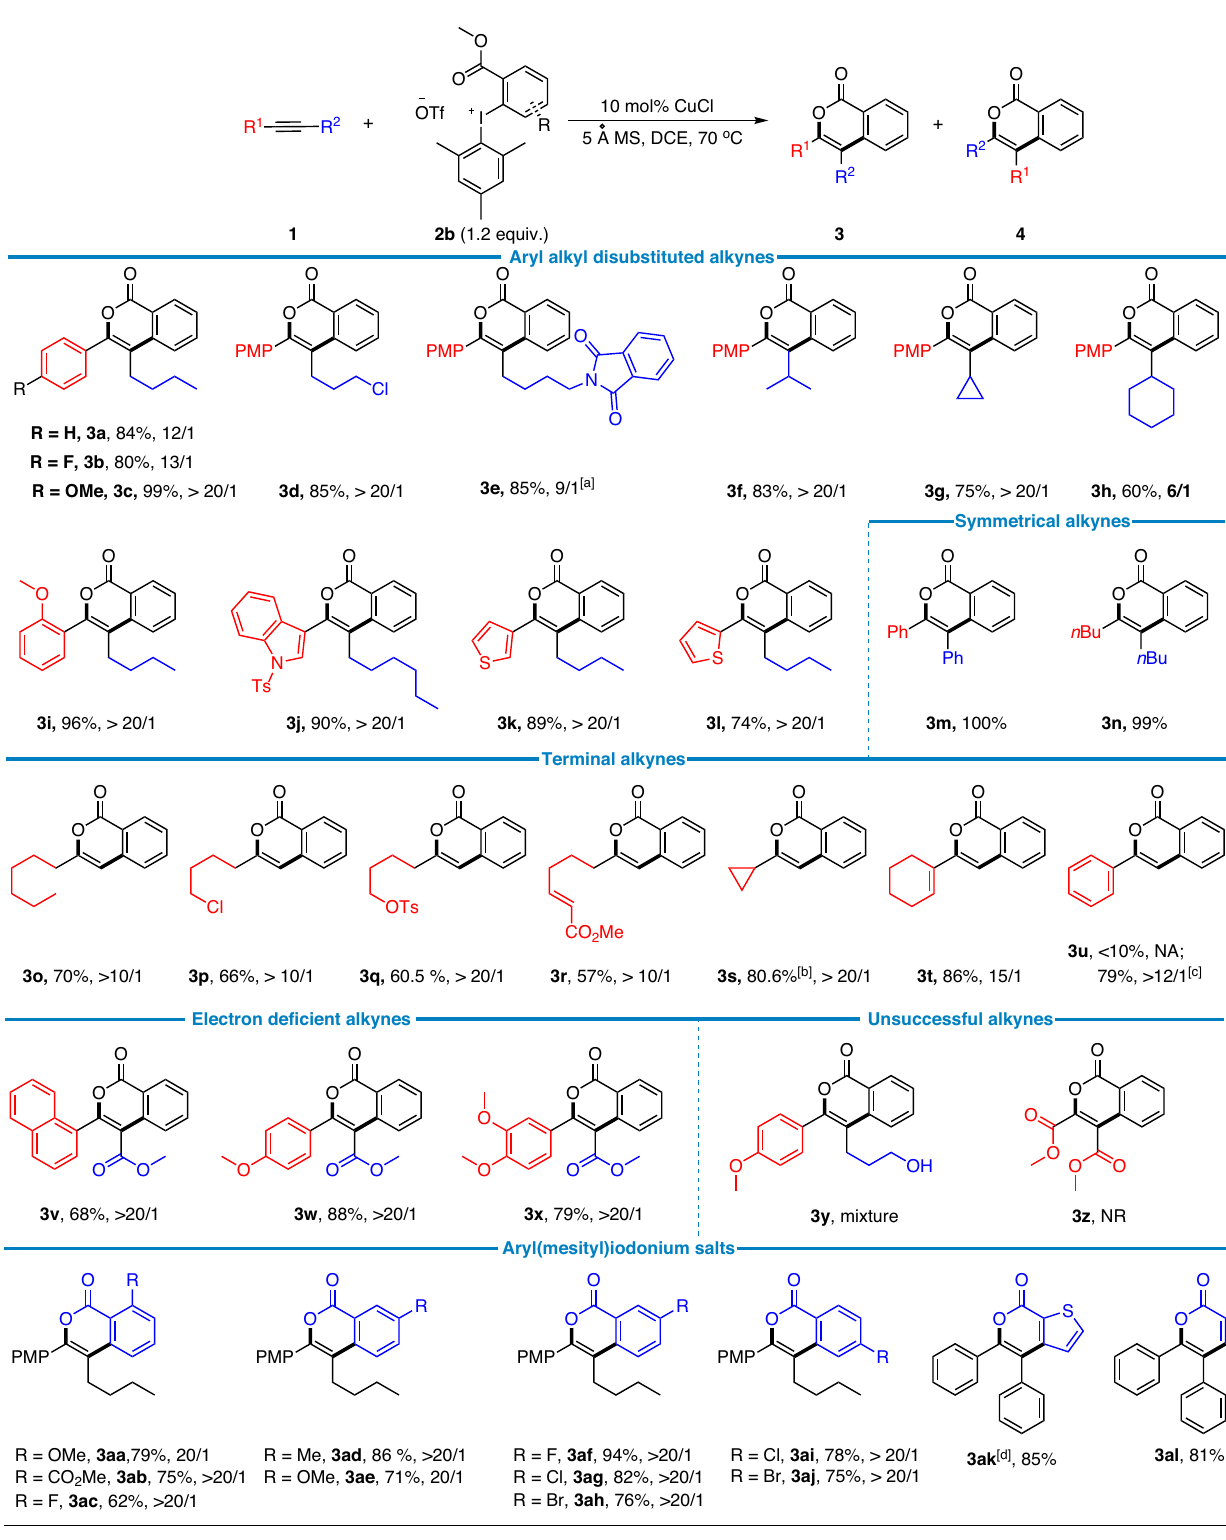
Fig. 2 Scope of the alkynes and diaryliodonium salts. Reactions were performed on 0.2 mmol scale. Isolated yields were given. The ratio of 3 and 4 was determined by crude 1 H NMR. [a] The ratio of 3e and 4e was determined by 1 H NMR of the puri fi ed product. [b] 1.5 equiv. of cyclopropylacetylene was used. [c] 1-Phenyl-2-(trimethylsilyl)acetylene was used. [d] 0.1 mmol